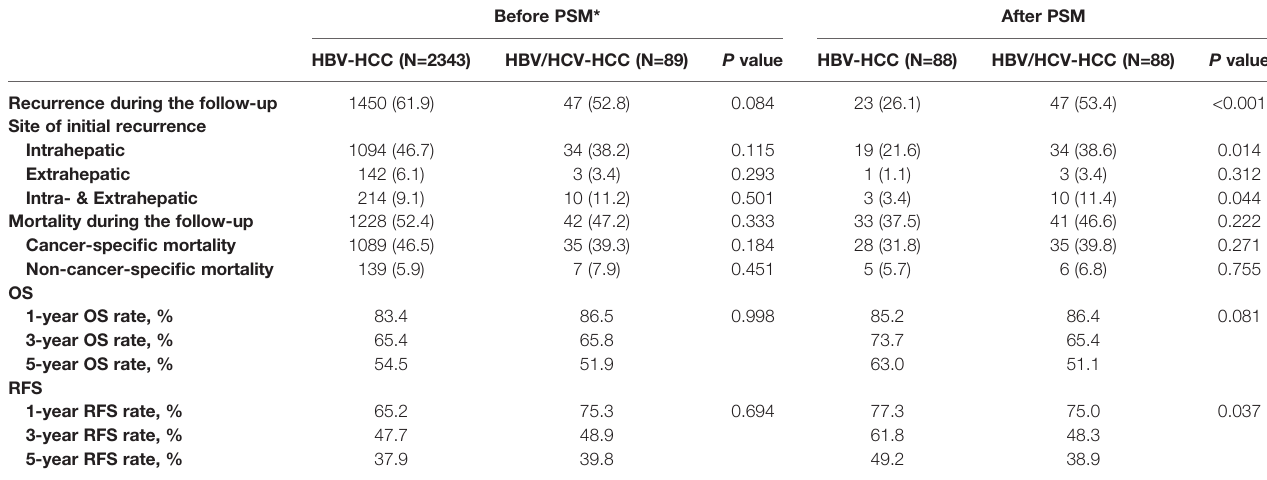
TABLE 2 | Comparisons of long-term outcomes between patients with HBV/HCV-HCC and HBV-HCC before and after propensity score matching. Before PSM* After PSM HBV-HCC (N=2343) HBV/HCV-HCC (N=89) P value HBV-HCC (N=88) HBV/HCV-HCC (N=88) P value Recurrence during the follow-up <0.001 Site of initial recurrence